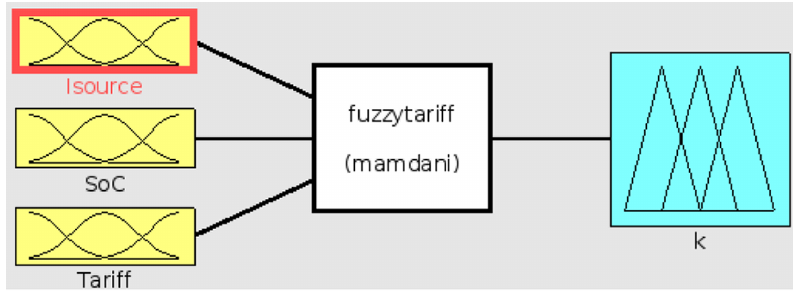
Figure 5. Proposed FLC architecture.